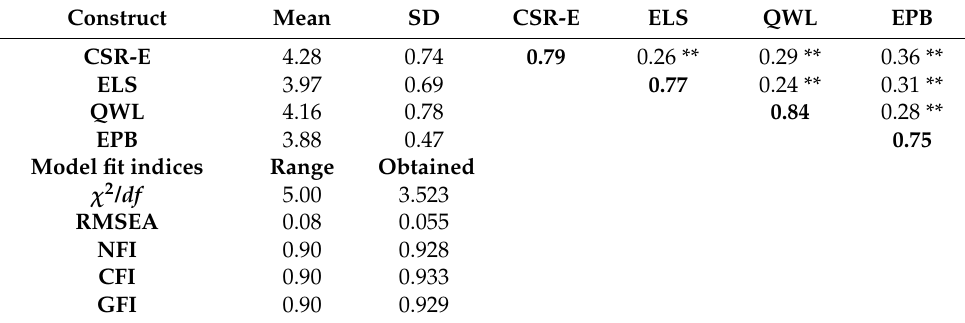
Table 3. Correlation, discriminant validity and model fit indices results.